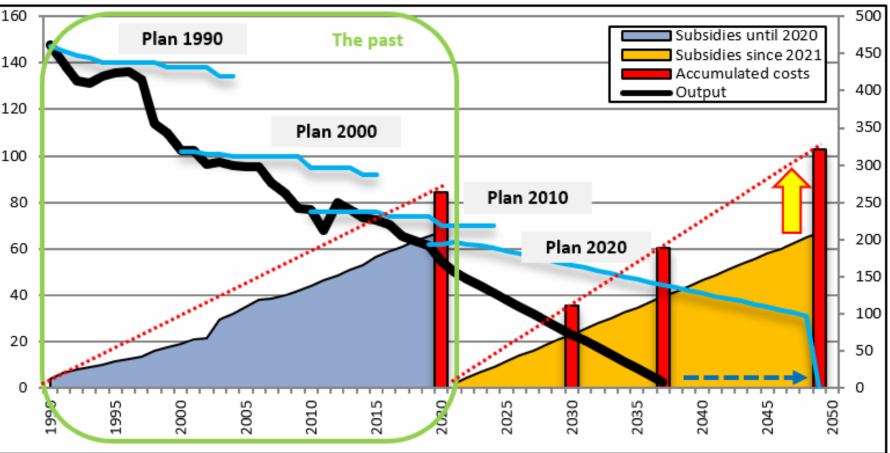
Figure 10. Coal output, subsidies and accumulated costs resulting from restructuring and planned coal phase-out in 1990–2020 and 2021–2049. Note: output—millions of tonnes, left axis; subsidies and costs—PLN billions, right axis. Source: as in Figure